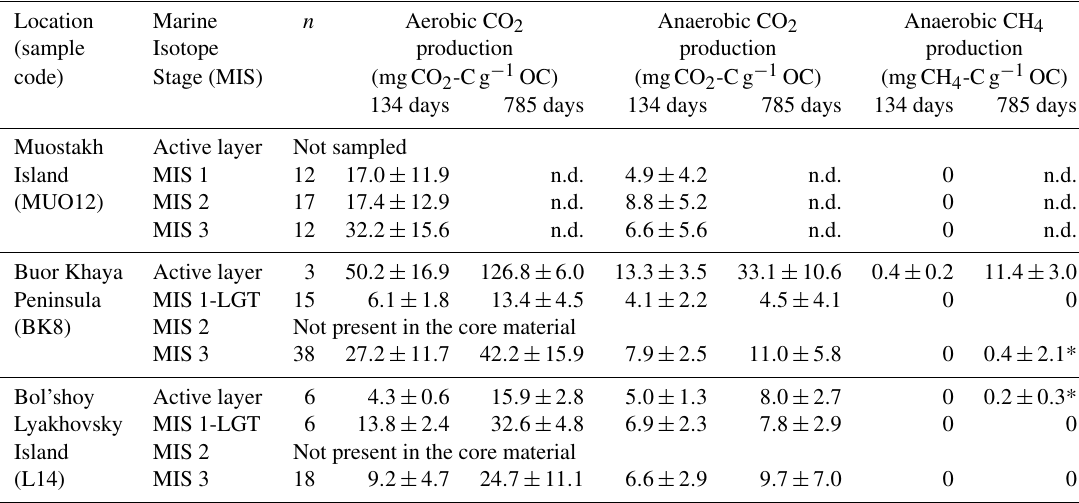
* Methanogenesis was only observed in two